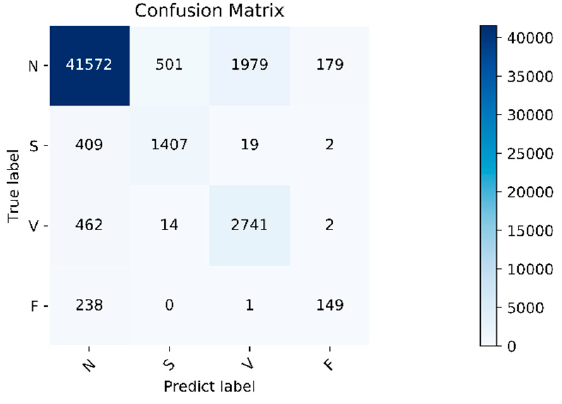
Figure 10. Confusion matrix. Normal heartbeat (N), supraventricular ectopic heartbeat (S), ventricular ectopic heartbeat (V), and fusion heartbeat (F).